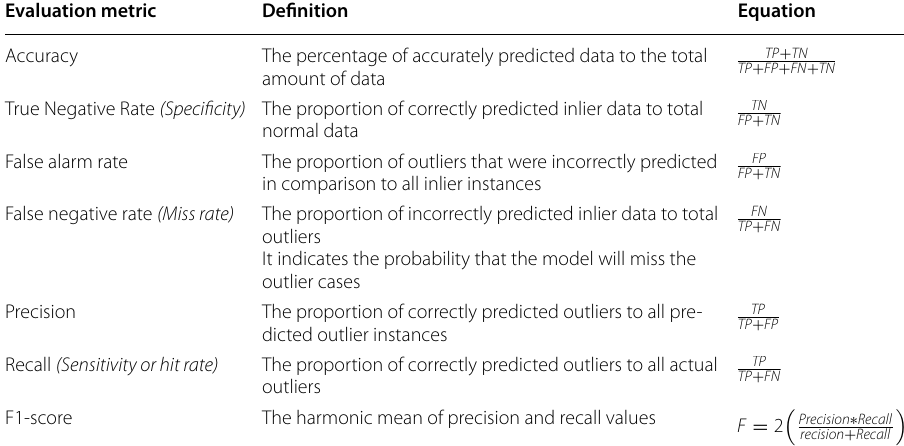
Table 3 The evaluation metrics Evaluation metric Definition Equation